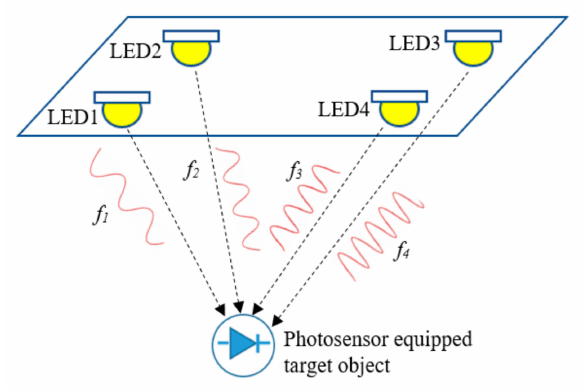
Figure 13. Overview of the VLP system. VLP: visible light positioning.